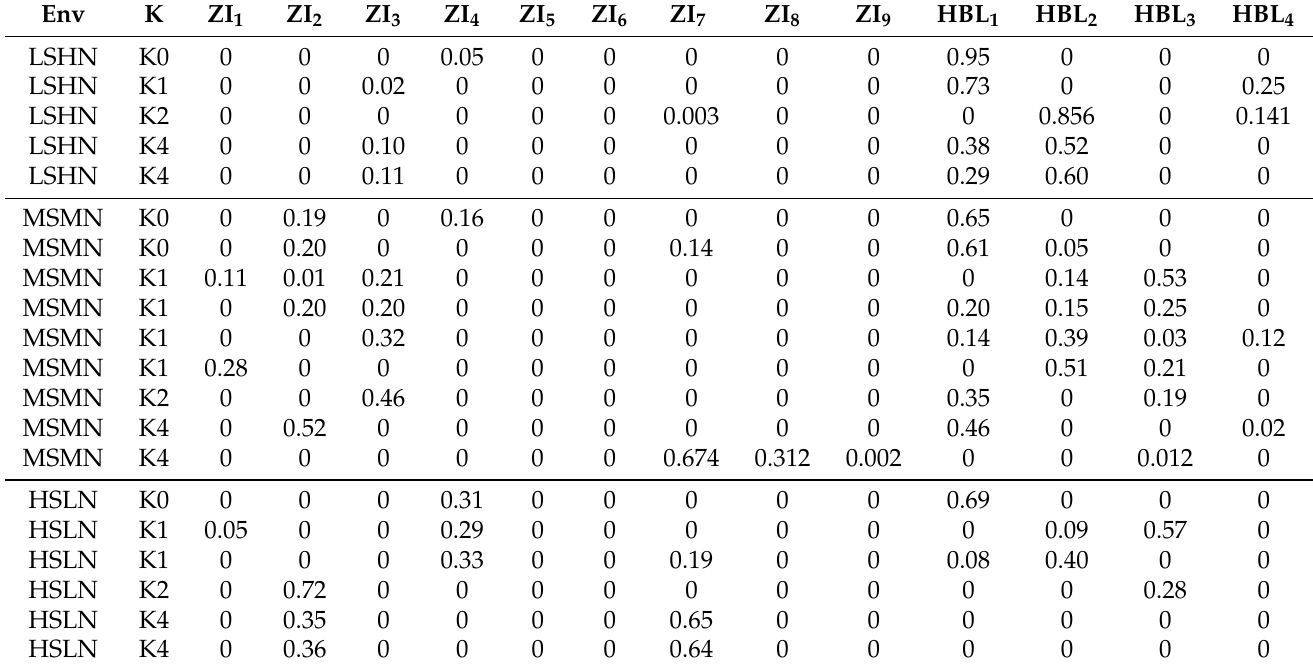
Table A15. Detailed Equilibria for games where the exploiter strategically chooses to spoof. Each row of the table describes one equilibrium found with its corresponding mixture of background strategies.